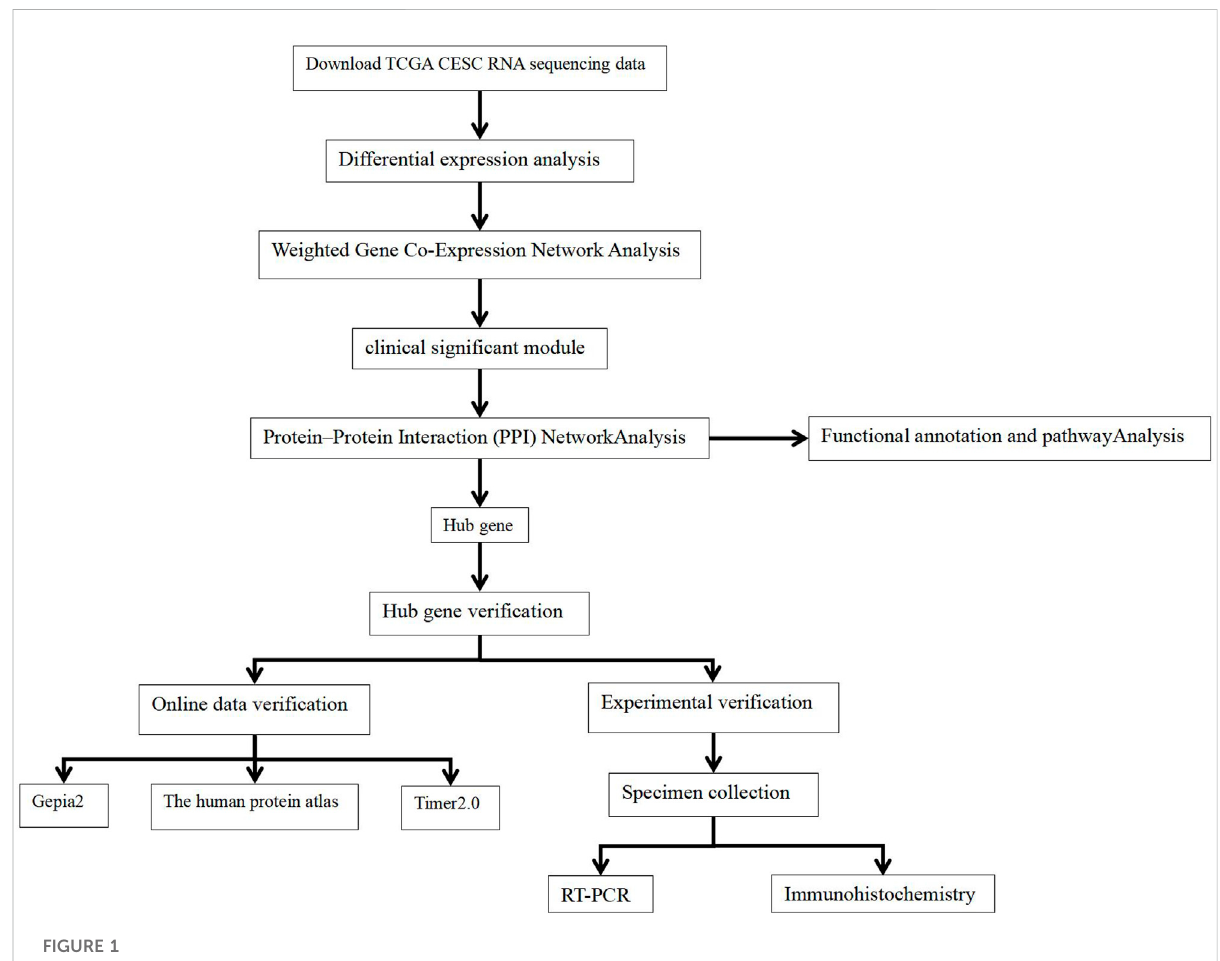
FIGURE 1 Flowchart for this